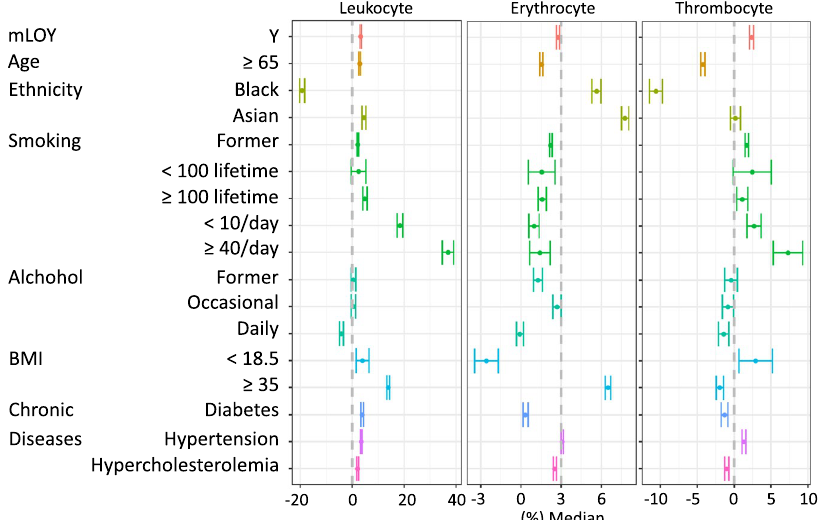
Figure 3. Relative impact of selected risk factors associated with leukocyte, erythrocyte, and thrombocyte counts. Multivariable linear regression models adjusted for age, age squared, race/ethnicity, smoking, alcohol consumption, body mass index (continuous variable), diabetes, hypertension, and hypercholesterolemia. The reference group for categorical variables were no mLOY, Caucasian, never smoker, never drinker, 18.5 ≤ body mass index < 25, no diabetes, no hypertension, no hypercholesterolemia. The point estimates, confidence interval, and p -values can be found in Table